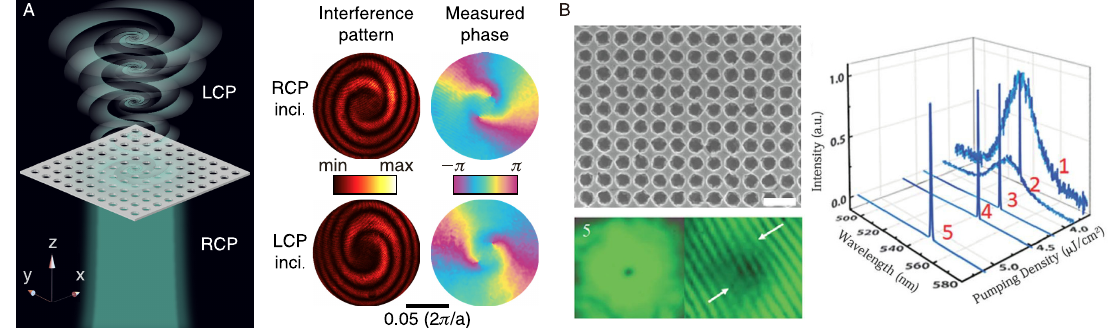
Figure6: (A) Left:theschematicviewof generatinganopticalvortexbeamwithaphotoniccrystalslab. Whena slightlyconvergentbeamwith a certain circular polarization and the chosen working wavelength is shined on the photonic crystal slab, the resonance-converted cross- polarized beam radiating from the slab would gain a spiral phase front. Right: measured interference patterns and extracted spiral phase distributions in the validating experiments. (B) A perovskite-based photonic-crystal-slab sample which can actively generate a vortex laser. With the increasing pumping power density, the sample clearly exhibits a lasing action as plotted in the right panel. The torus-shaped beam profile and the interference pattern on the left show the vortex behavior of the generated laser beam. (A) is adapted from [117], and (B) is adapted from